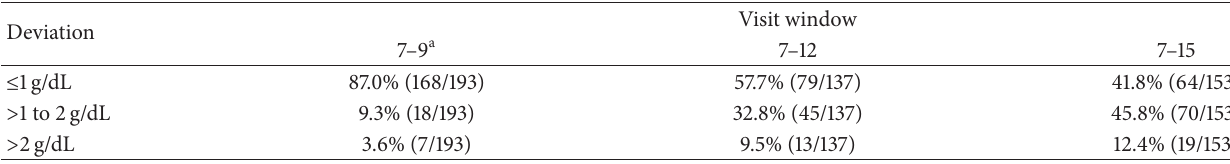
Table 4: Deviation of Hb from intraindividual mean